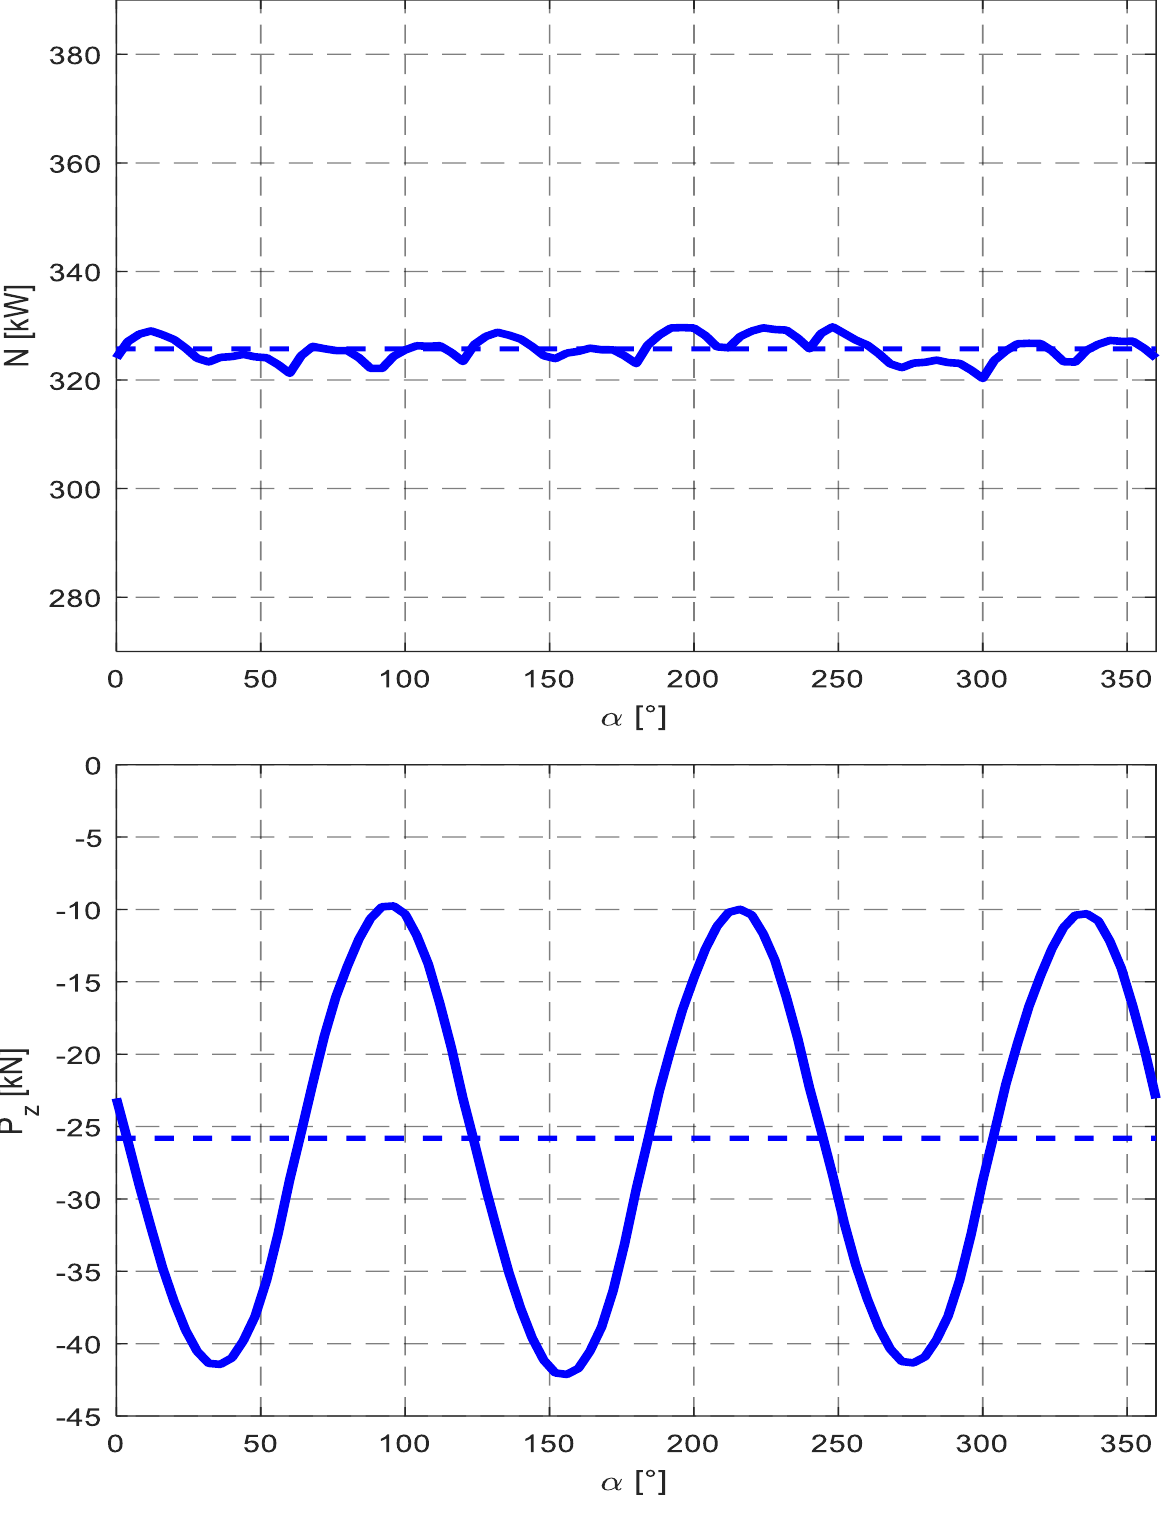
Figure 16. Waveform of the values of power N and cutting head impact force in the direction of shearer’s advance P z for pick arrangement 1d.